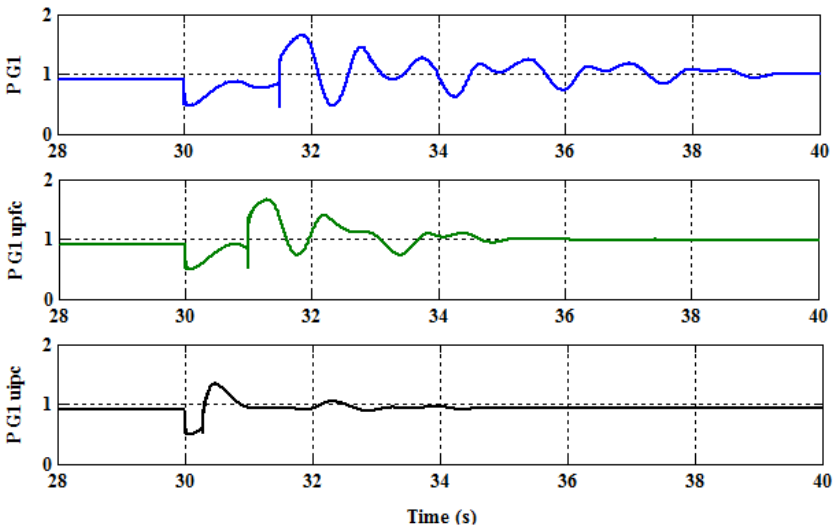
Figure 5. The output power of Generator 1 (left side G1) in three different modes, including without compensator (P G1), with unified power flow controller (UPFC) (P G1upfc), and with UIPC (PG1uipc). Figure 6 also shows the output power of generator 2 (left side G2) in the three different states. As seen, PV-based UIPC shows enhanced stability performance in both transient and steady-state cases. It is obvious that after the fault, the fluctuations can be canceled very fast when using the UIPC. In fact, the UIPC indicates a fast transient response and zero steady-state, unlike the UPFC. The output power fluctuations are successfully mitigated compared to the other two states. The UPFC can enhance transient stability but with a more noteworthy delay than the UIPC. Figure 7 depicts the speed of generators 1 and 2 (left side G1 and G2) in three states using UIPC and UPFC and without using them. As seen, the UIPC effectively can reduce deviations and velocity